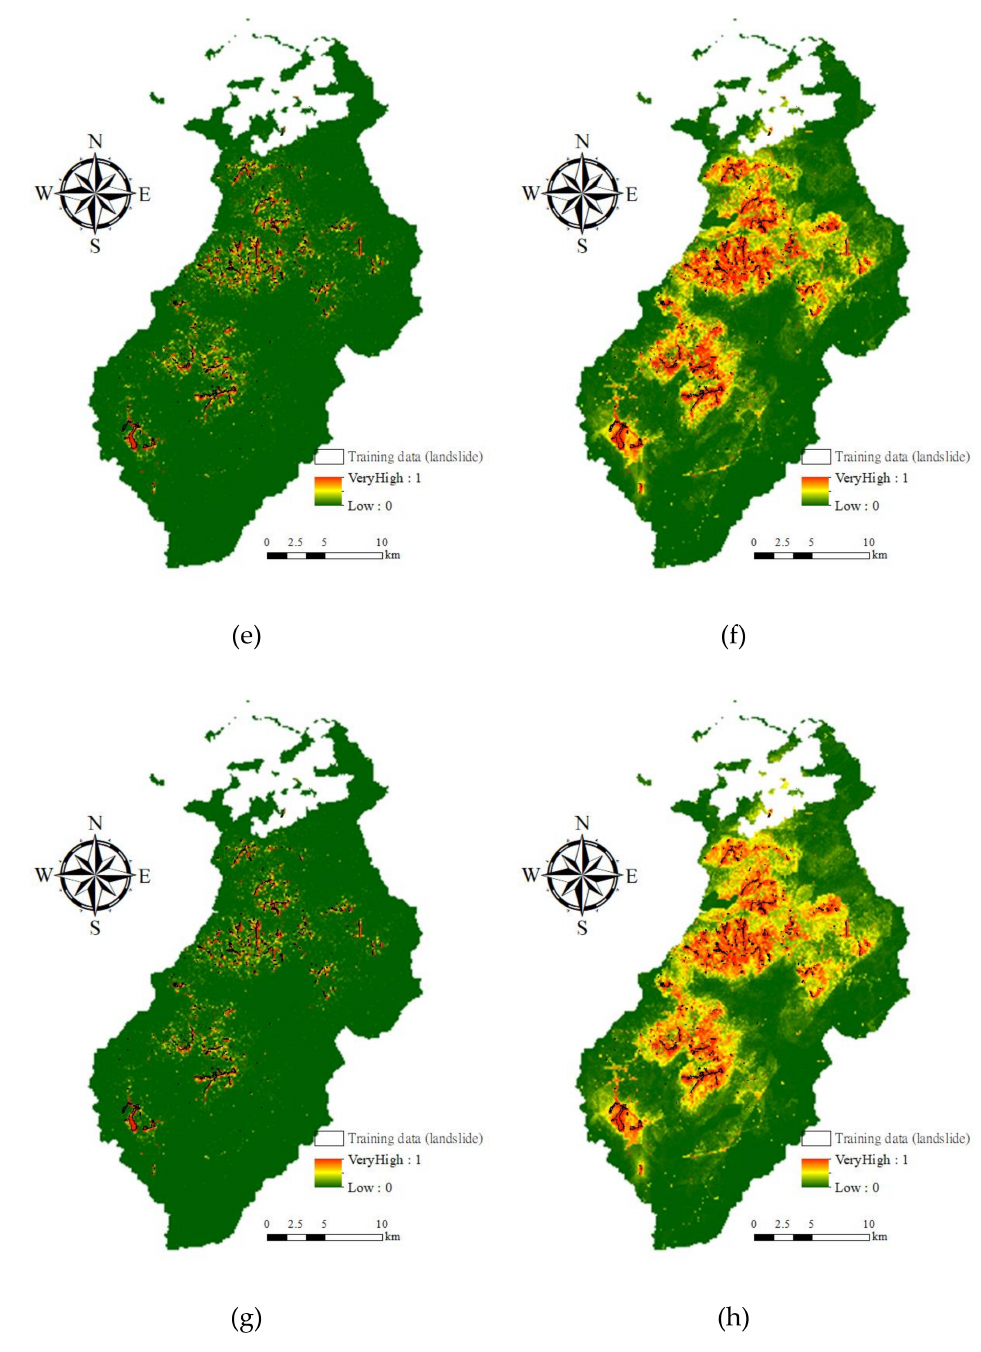
Figure 10. The multi-temporal landslide susceptibility maps generated ( a ) without cost analysis in the 1:1 case,( b ) with cost = 50 in the 1:1 case, ( c ) without cost analysis in the 1:4 case, ( d ) with cost = 500 in the 1:4 case, ( e ) without cost analysis in the 1:7 case, ( f ) with cost = 1000 in the 1:7 case, ( g ) without cost analysis in the 1:10 case, and ( h ) with cost = 3000 in the 1:10